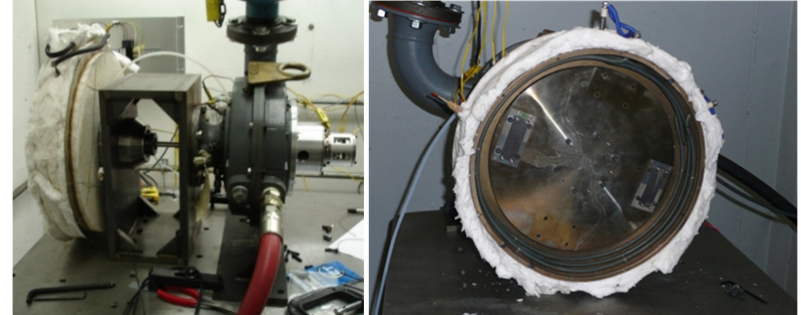
Figure 13. Spin test rig developed by Aerodyn Engineering, Inc. for high temperature and high g-load testing. Left : entire test rig. Right : inside the